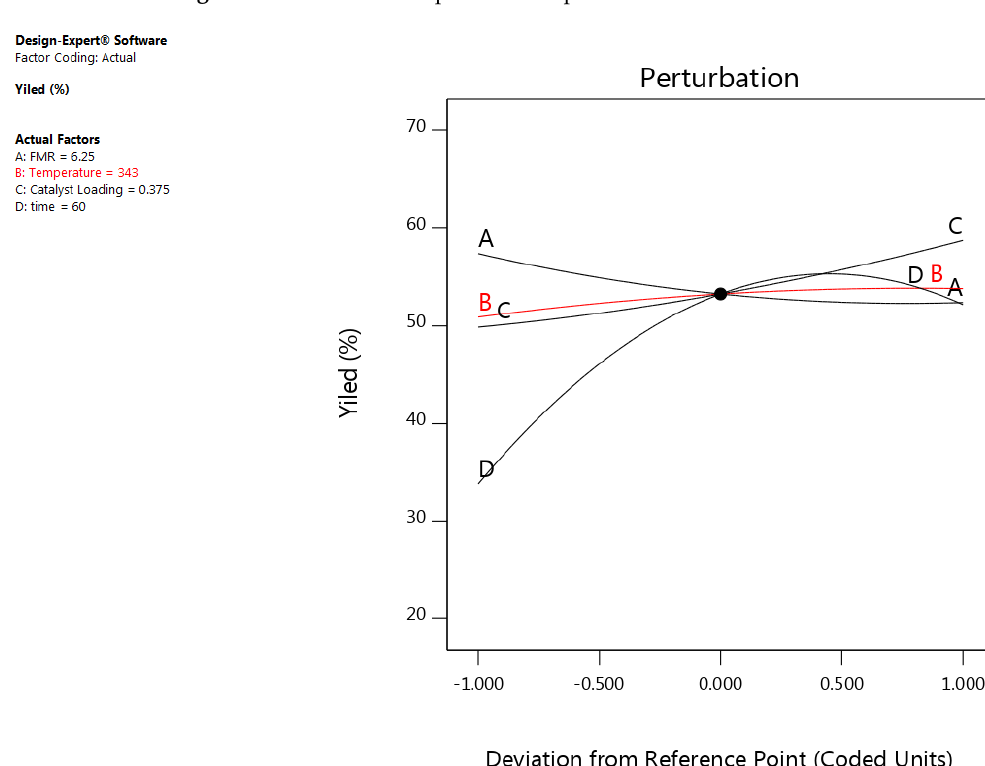
Figure 3. Residual versus predicted response.